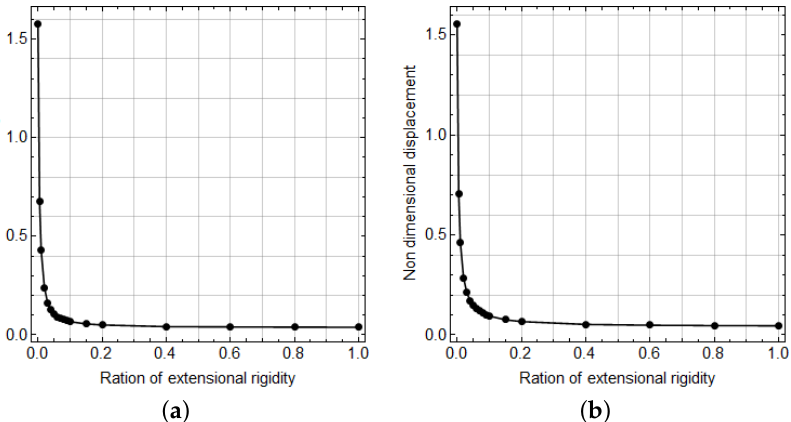
Figure 17. Effect of the ratio of extensional rigidity α in Case 1-4 with side vertical reinforcing member: ( a ) nondimensional stress; ( b ) nondimensional